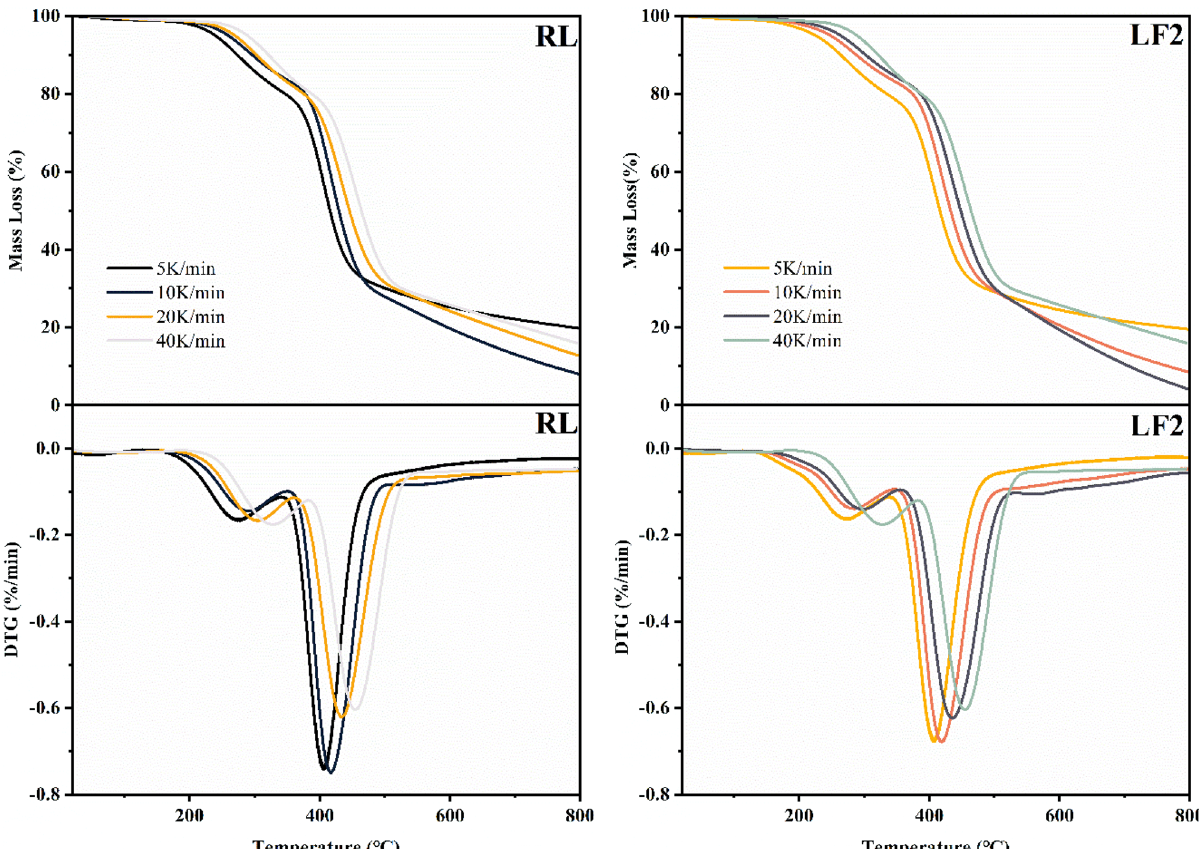
Figure 4. The TG and DTG curves of RL and LF2 four different heating